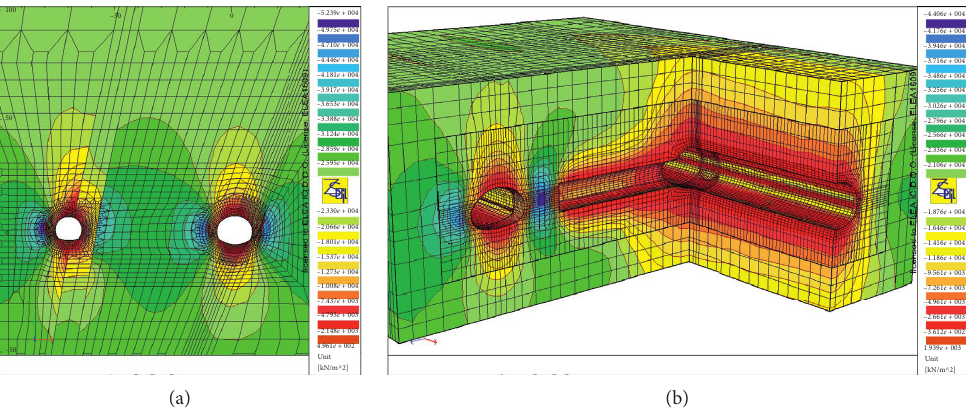
Figure 2: Example of 2D (a) and 3D (b) FEM analysis of stress state in the surrounding rock.